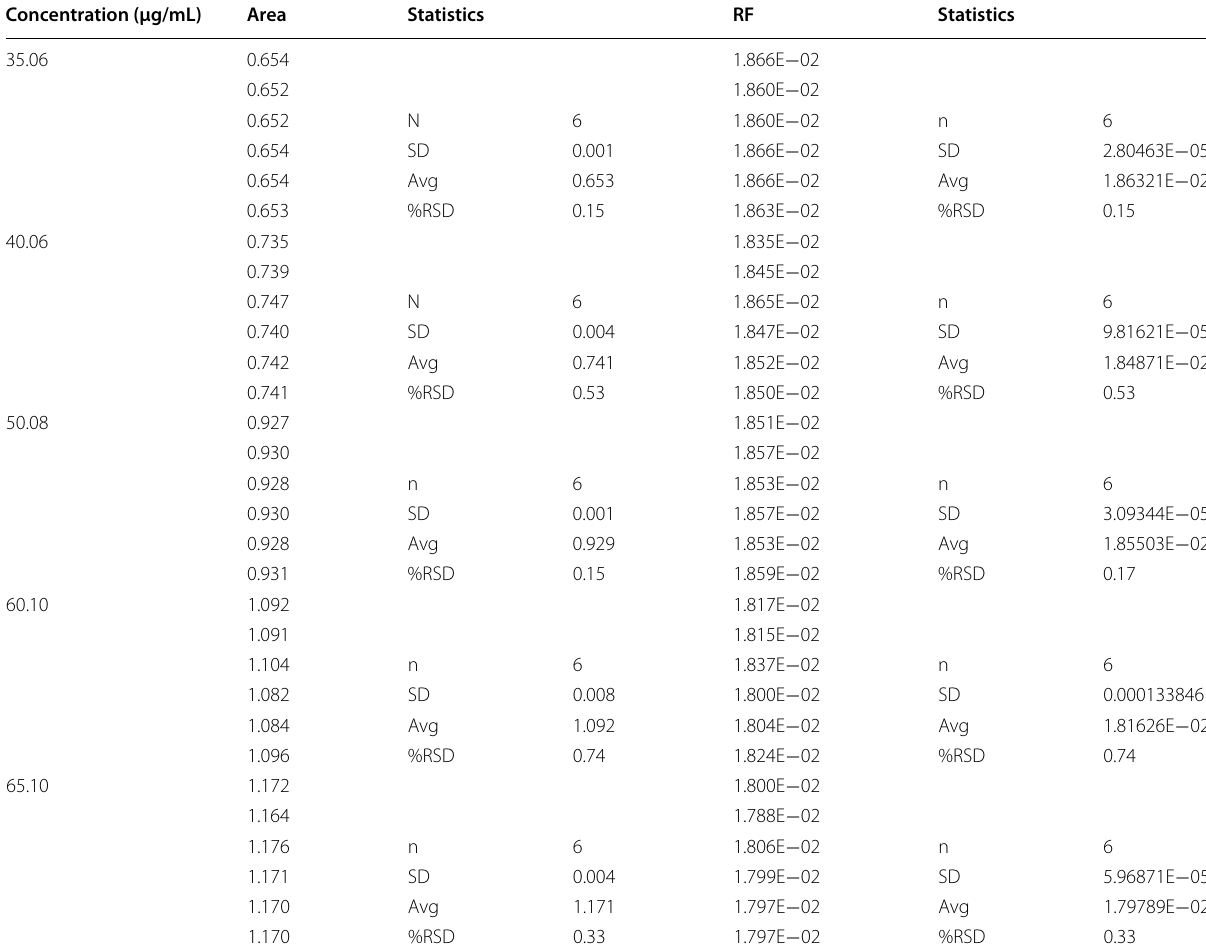
Table 4 Results for linearity and response factor (RF) determinations Concentration